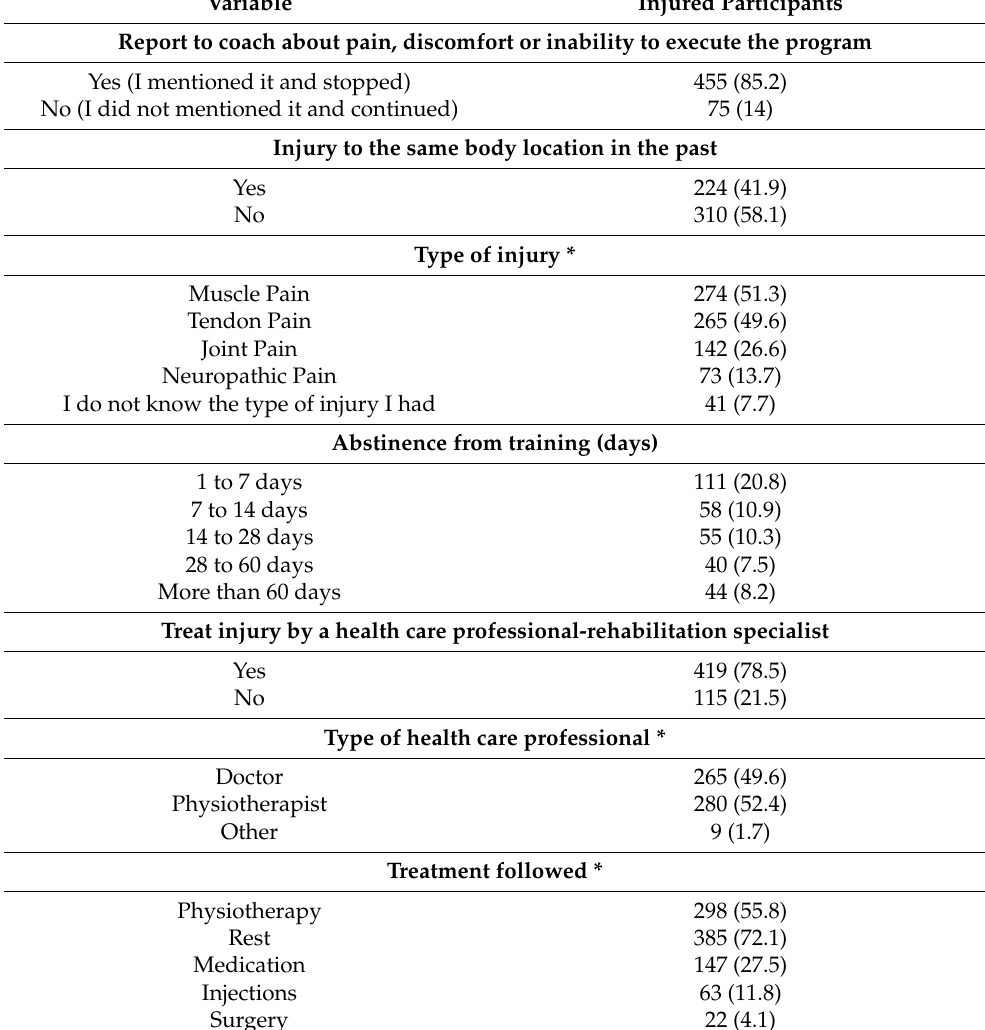
Table 5. Descriptives of other variables in injured